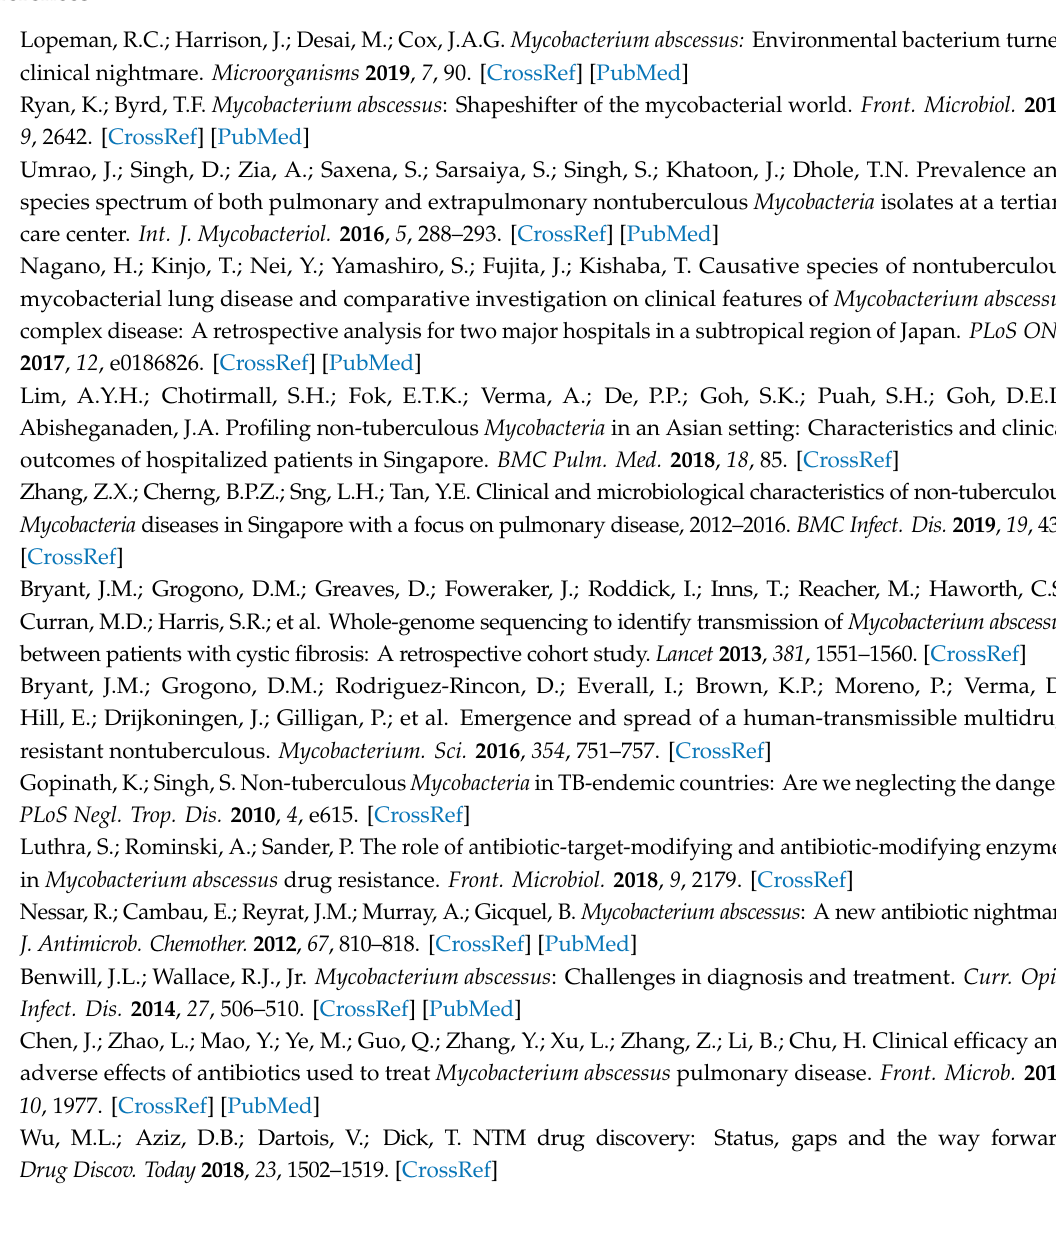
Figure S1: Time course analysis of macrophage viability post-infection, Figure S2: Post-infection washes remove extracellular bacteria, Figure S3: Clarithromycin and amikacin treatment reduce M. abscessus bacterial load, Figure S4: Amikacin and clarithromycin treatment does not alter macrophage viability, Figure S5: THP-1 infection with M. abscessus